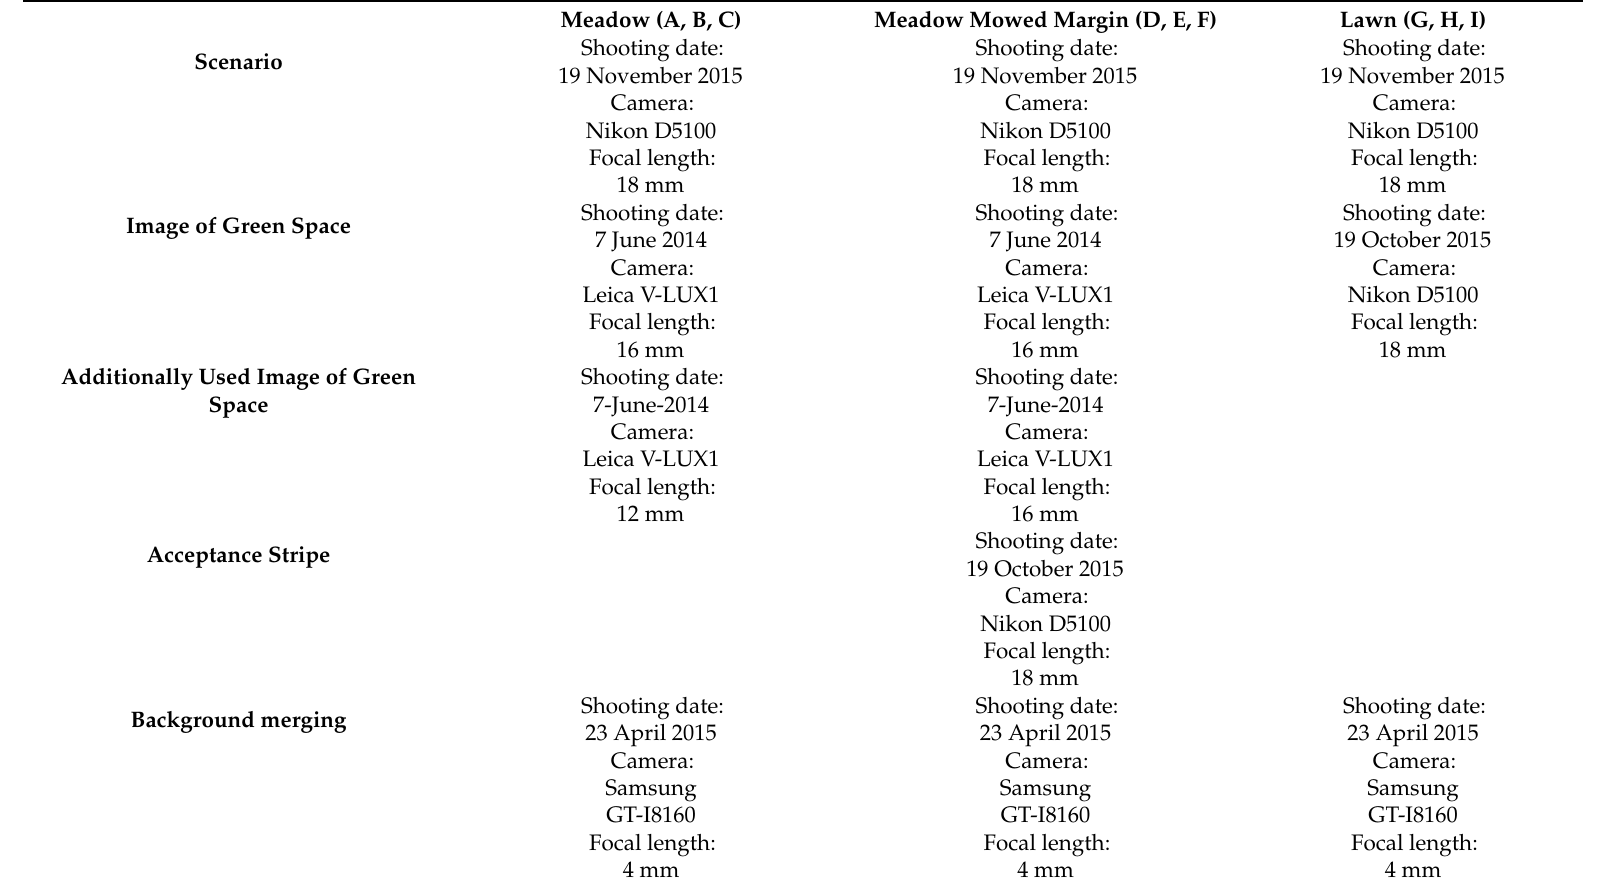
Table A6. Photo usage and details of Question